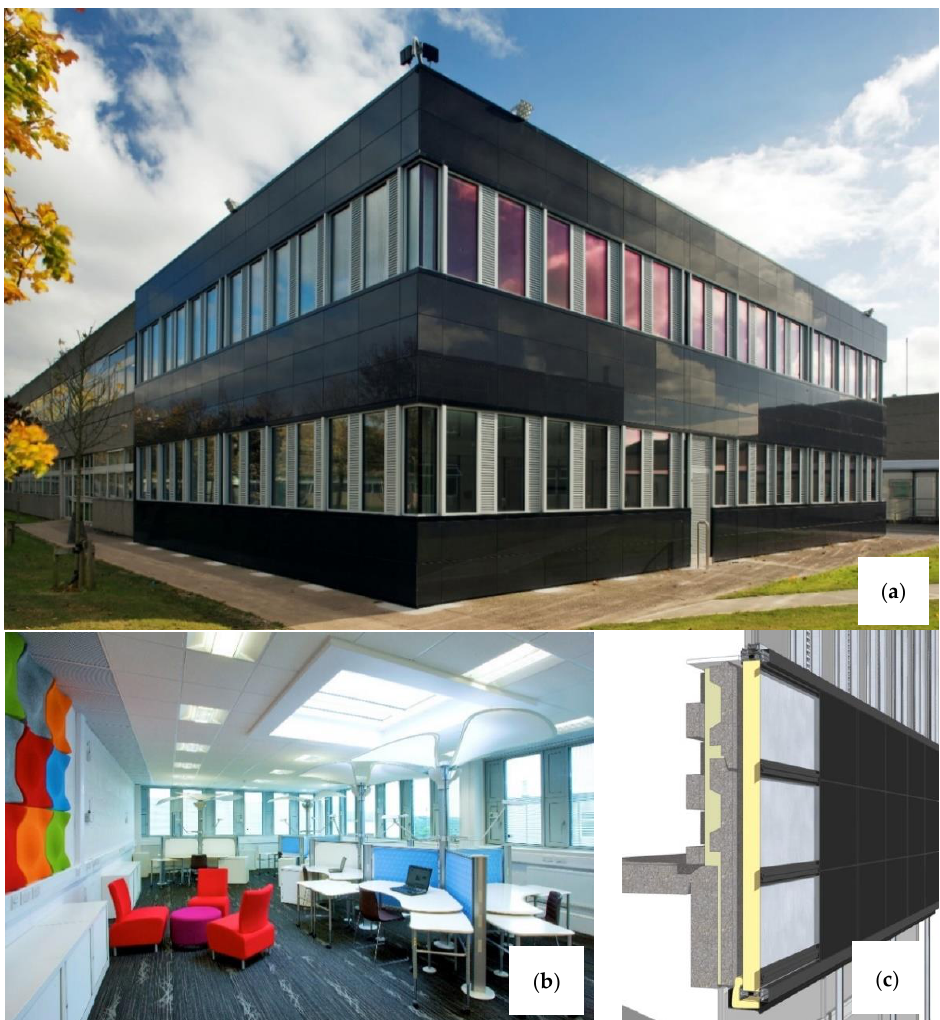
Figure 1. NBERT in the zero2020 building: ( a ) image of exterior of retrofitted building; ( b ) image of open plan office with MCSL ventilation system; ( c ) image of high-performance retrofitted wall detail.